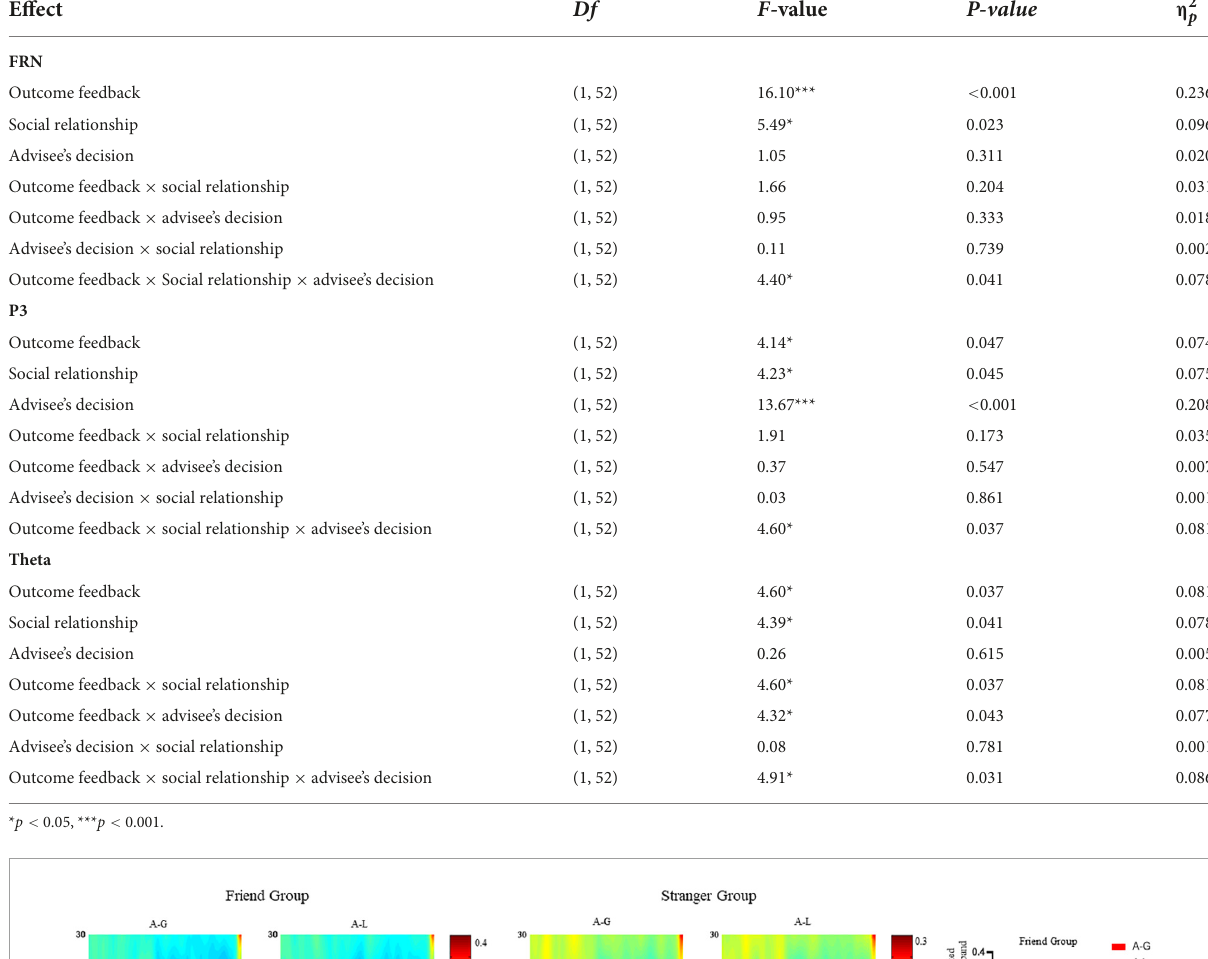
TABLE 2 Summary of the repeated-measures ANOVA performed on FRN, P3, and Theta.